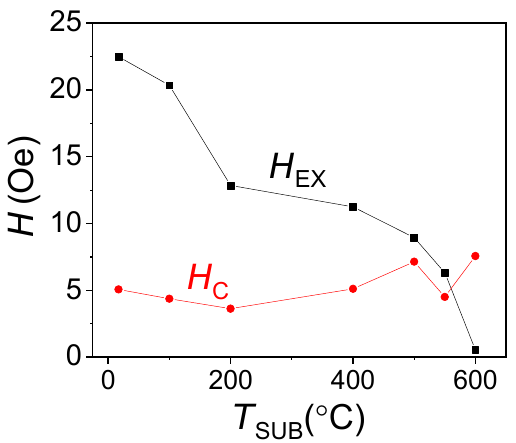
Figure 5. Exchange bias and coercivity dependence on the substrate temperature in NiFe (40 nm)/FeMn (20 nm) structures.